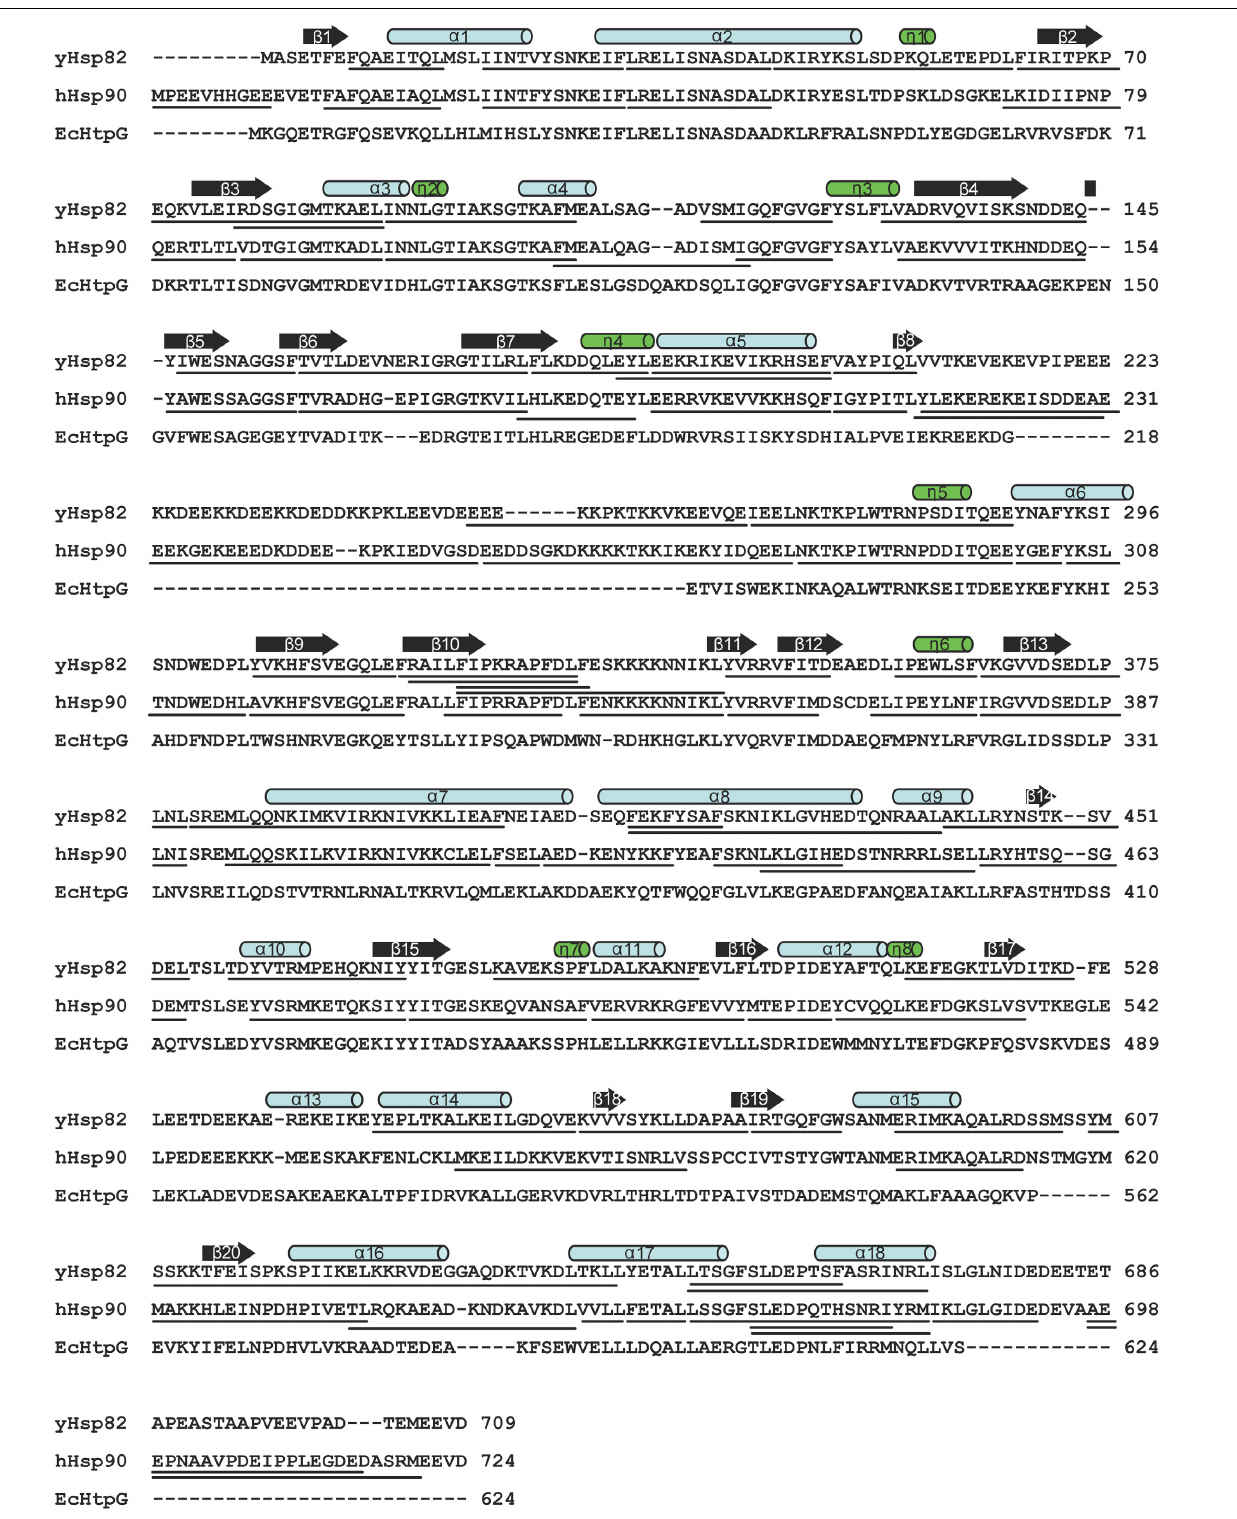
( β 1–20) according to the crystal structure of yHsp82 (PDB ID code 2CG9) are indicated above the alignment. The lines under yHsp82 and hHsp90 sequences indicate the peptic fragments that were analyzed in this